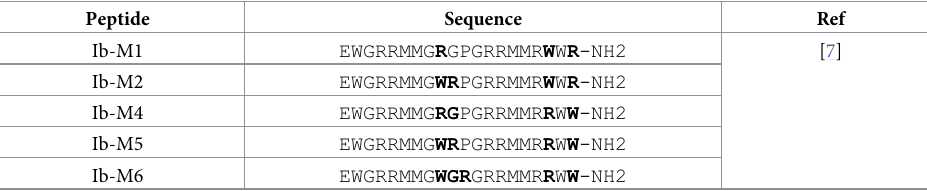
Table 1. Amino acid sequences of the peptides used in this study.